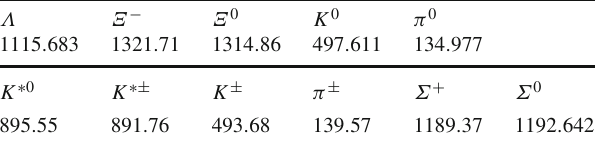
corresponding Feynman diagrams are shown in Figs. 2 and 3, respectively.